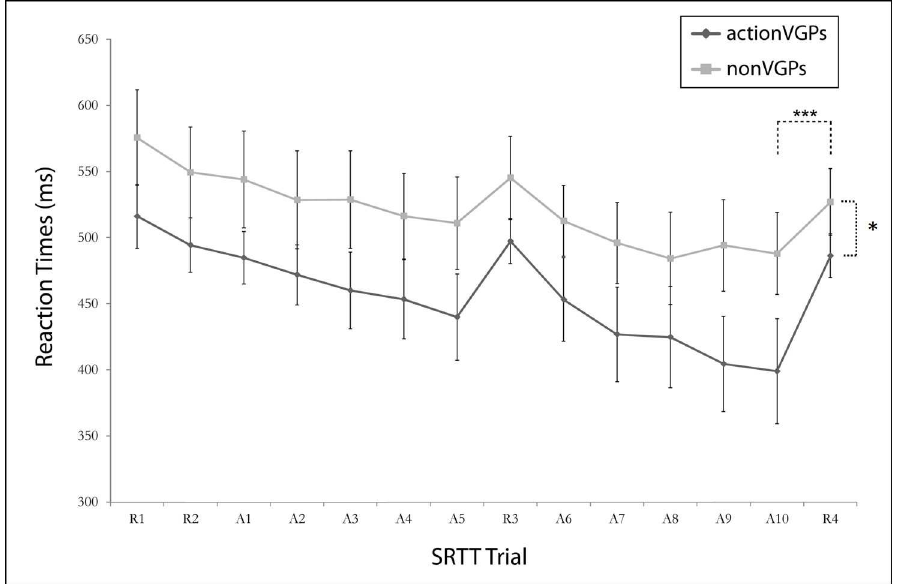
Fig 2. The general trend of the averagereaction times (RT) are displayed in random and sequence blocks on the SRTT. However, the analysiswas conductedon blocks A10 and R4. Motor